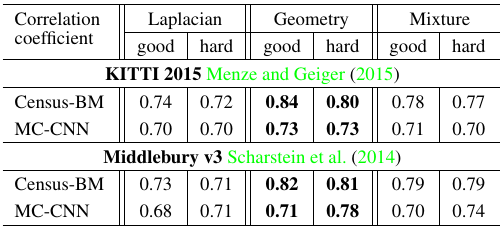
Table 4. Comparison of the three uncertainty models. For details on the evaluation procedure, please refer to Table 2. While the three uncertainty models have only minor differences based on the AUC metric, the proposed geometry-aware model exceeds other models by a wide margin considering the correlation coefficient metric.